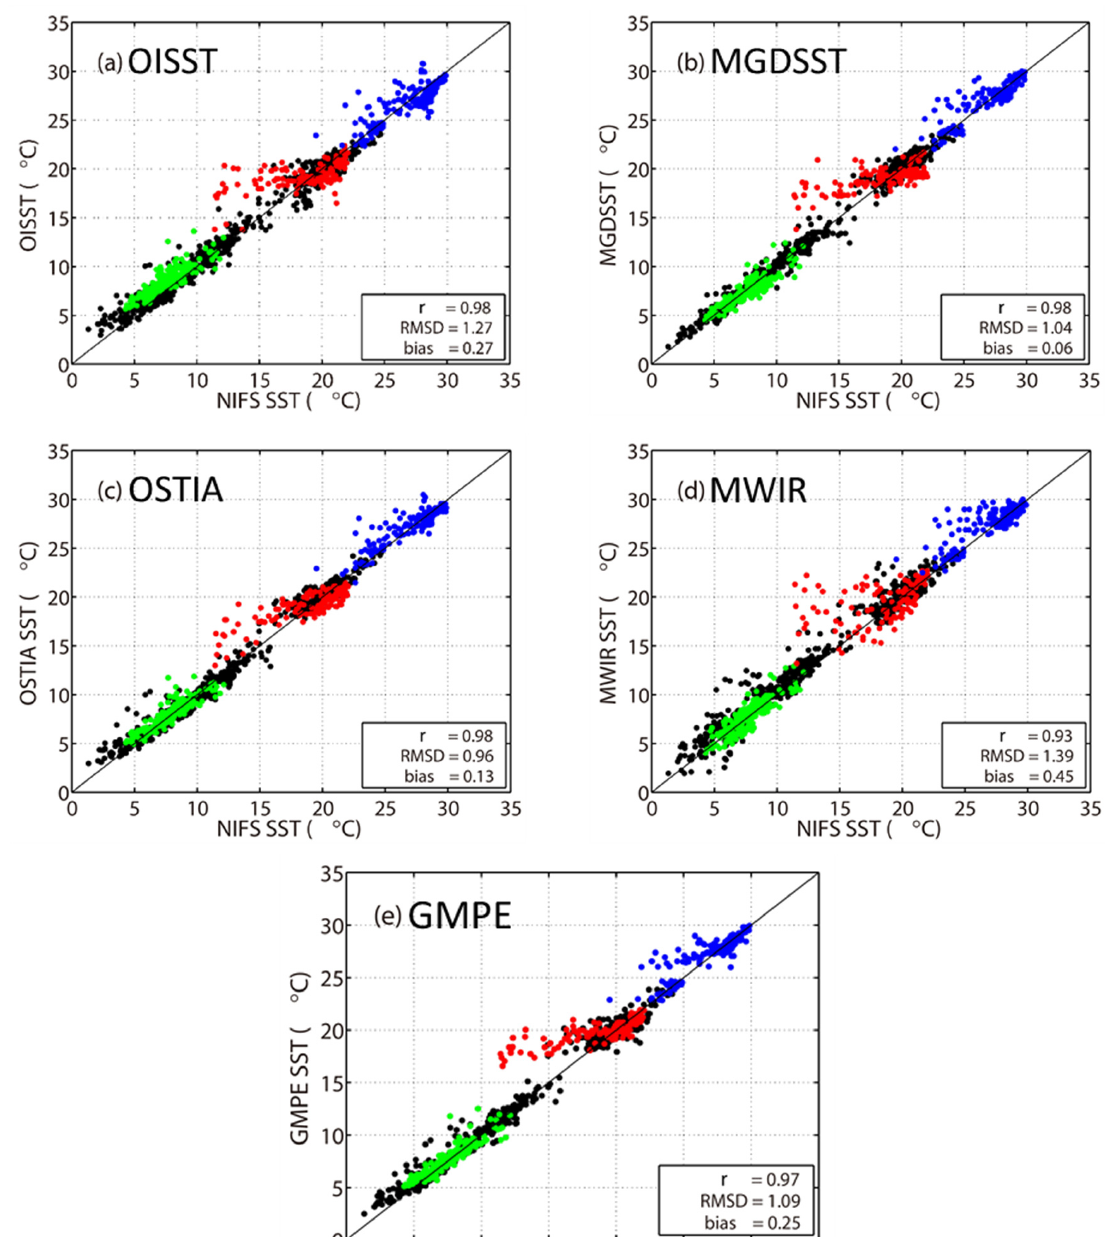
Figure 3. Comparison between the SST data measured by the in situ CTD (NIFS SST) and the global gridded datasets ( a ) OISST, ( b ) MGDSST, ( c ) OSTIA, ( d ) MWIR, and ( e ) GMPE. Red, blue, green, and black dots correspond to the SSTs observed in June, August, December, and other months, respectively. r is the correlation coefficient. Table 3. Root mean square difference ( RMSD) and bias of SST data obtained from in situ (the ocean buoys and conductivity-temperature-depth (CTD) measurements and remote sensing (satellite observation). The smallest RMSD and bias relative to KB, SB, and NIFS observations are given in bold face. The number of matchup data is given in parentheses.